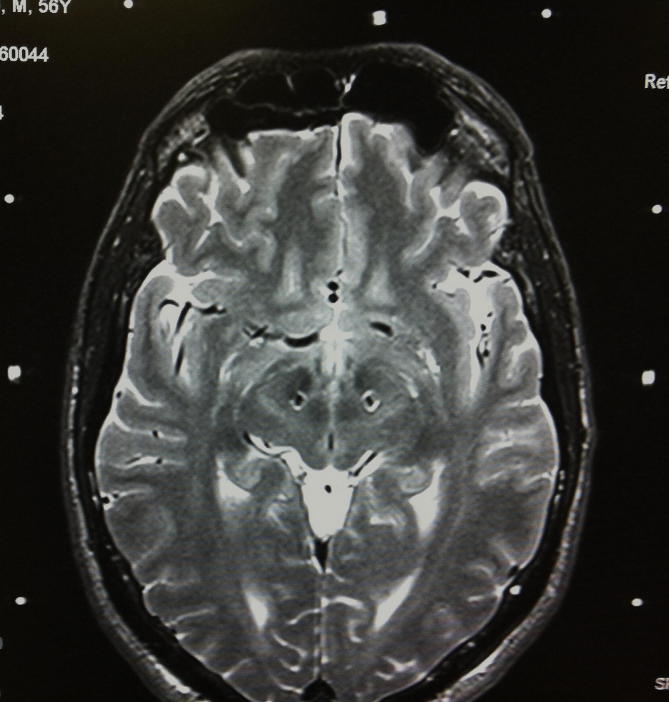
Immediate post-implant stereotactic axial T2-weighted MR scan at the level of the lowest contact of the DBS electrodes lying in the posterior part of the ventral STN. Electrodes were connected to an accessory kit, typically both connectors being tunnelled to the left temporoparietal area and externalized through the frontal region. Electrode locations were confirmed using postoperative stereotactic imaging